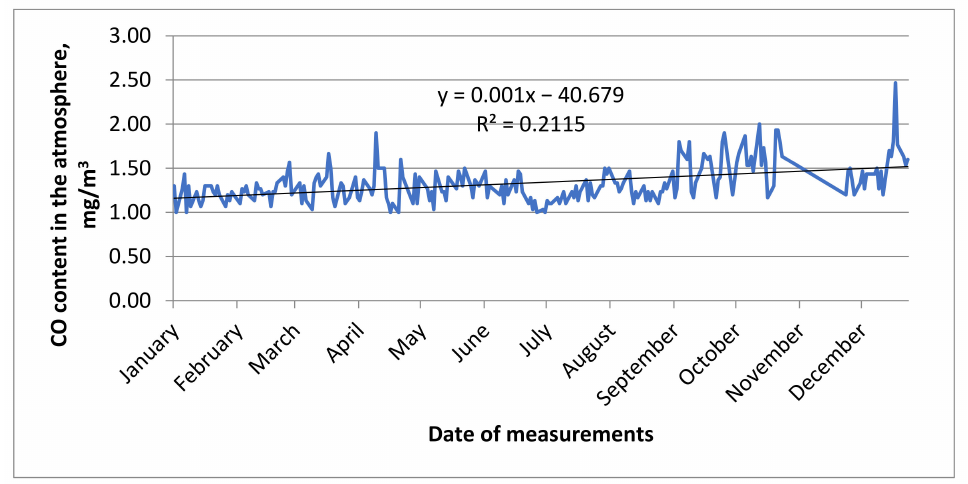
Figure 8. Average daily carbon monoxide concentrations in atmospheric air during the year, mg/m 3 .